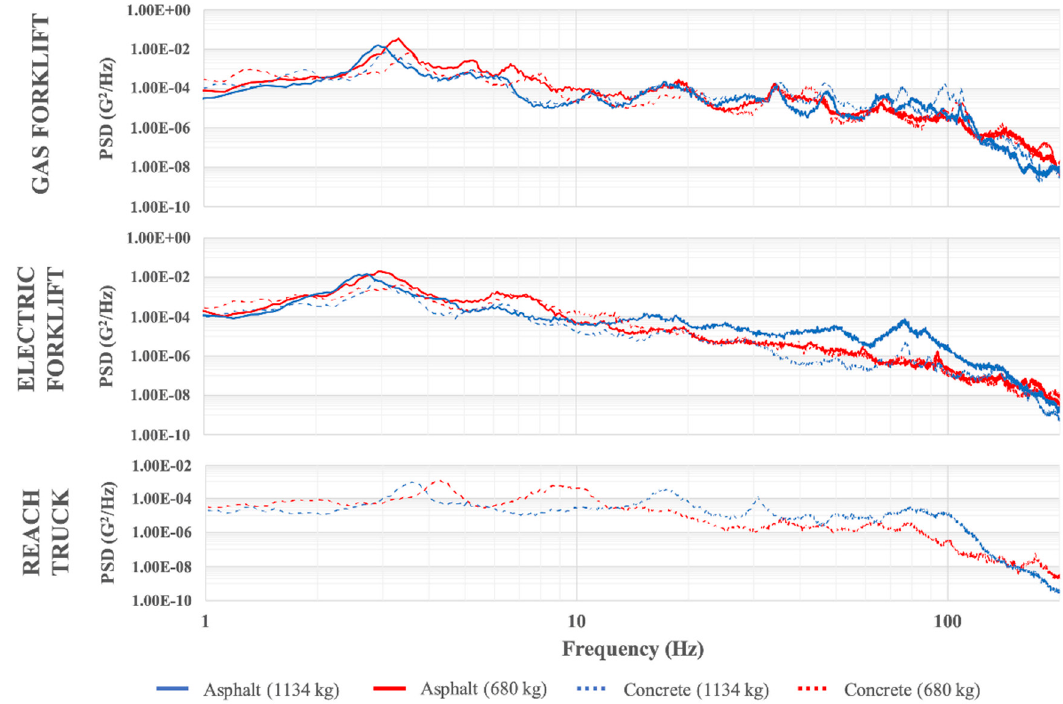
Figure 8. PSD of the three investigated forklifts as a function of payload (680 kg and 1134 kg).